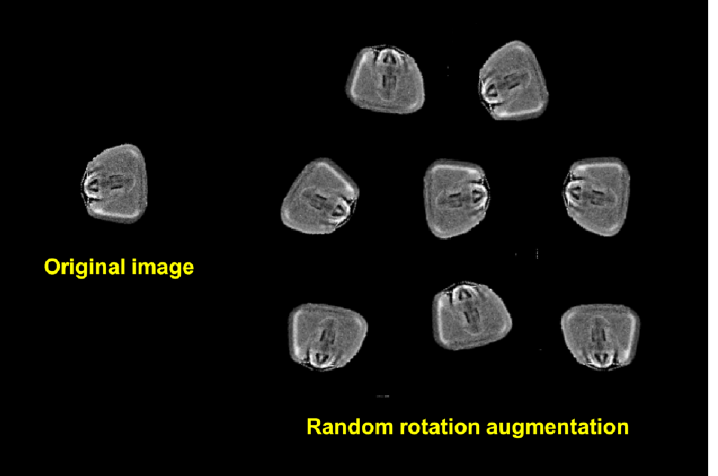
Figure 1. Data augmentation method based on random rotations and flips (mirror effect) used for X-ray image recognition in classes of maize grains infested and non-infested by Sitophilus zeamais .